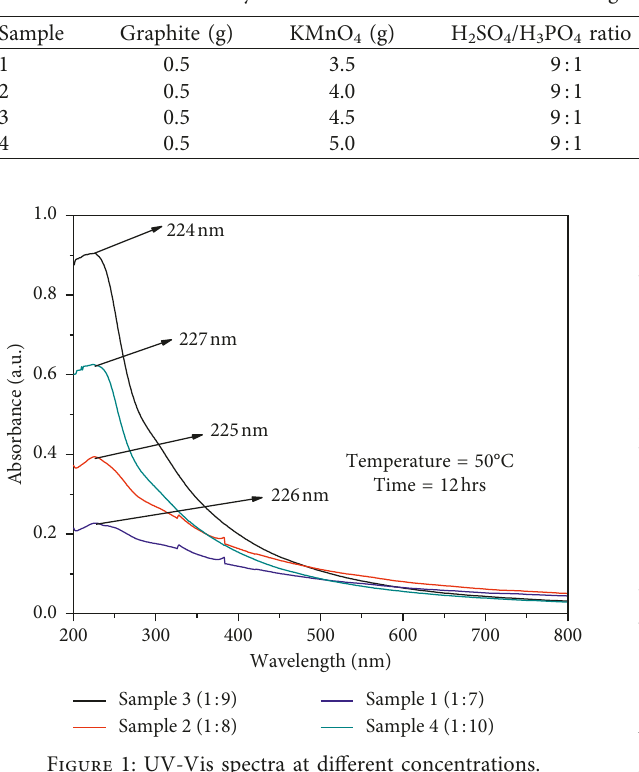
S CHEME 2: Visual characterization of (a) GTO solution and GO solution, film, and powder and (b) rGO solution, film, and powder. Solutions in (a) and (b) were formed at the 1:1wt./v ratio of the sample with distilled water as the solvent, and their images were taken using a video camera. Table 1: Synthesis of GO at different mixture weight ratios of graphite and potassium permanganate.